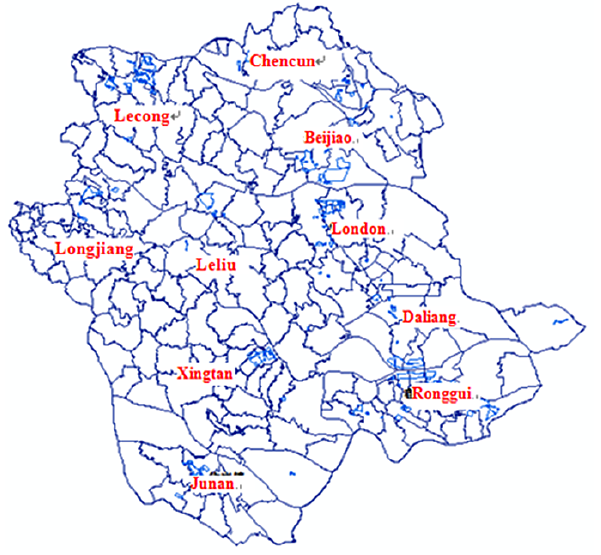
Figure 1. The administrative division of the “Three Old” project of Shunde.